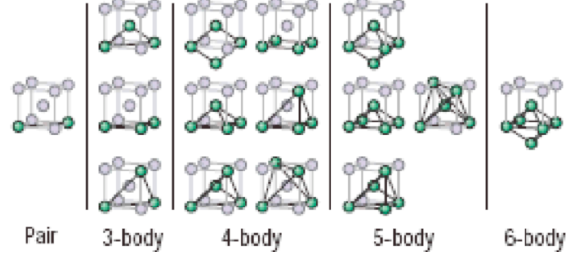
Fig. 5. Types of many-body interactions considered for the 3nn approximation.